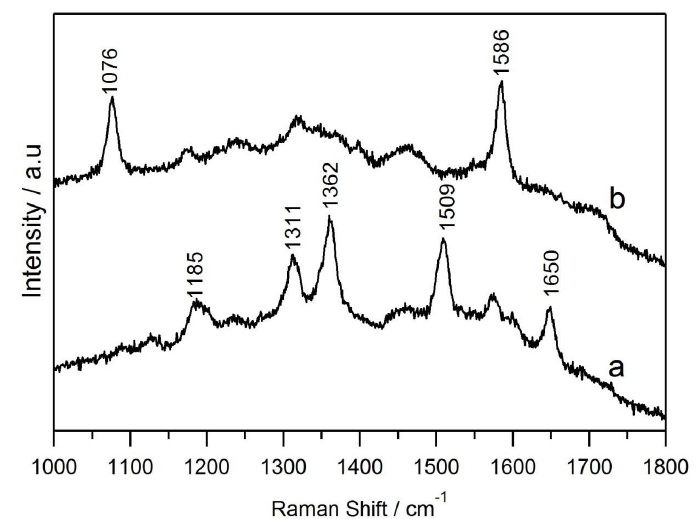
Figure 10. Surface-enhanced Raman scattering (SERS) spectra of ( a ) rhodamine 6G (R6G); ( b ) 4-mercaptobenzoic acid (MBA) on Au-Ag NWs obtained at the laser wavelength of 632.8 nm.